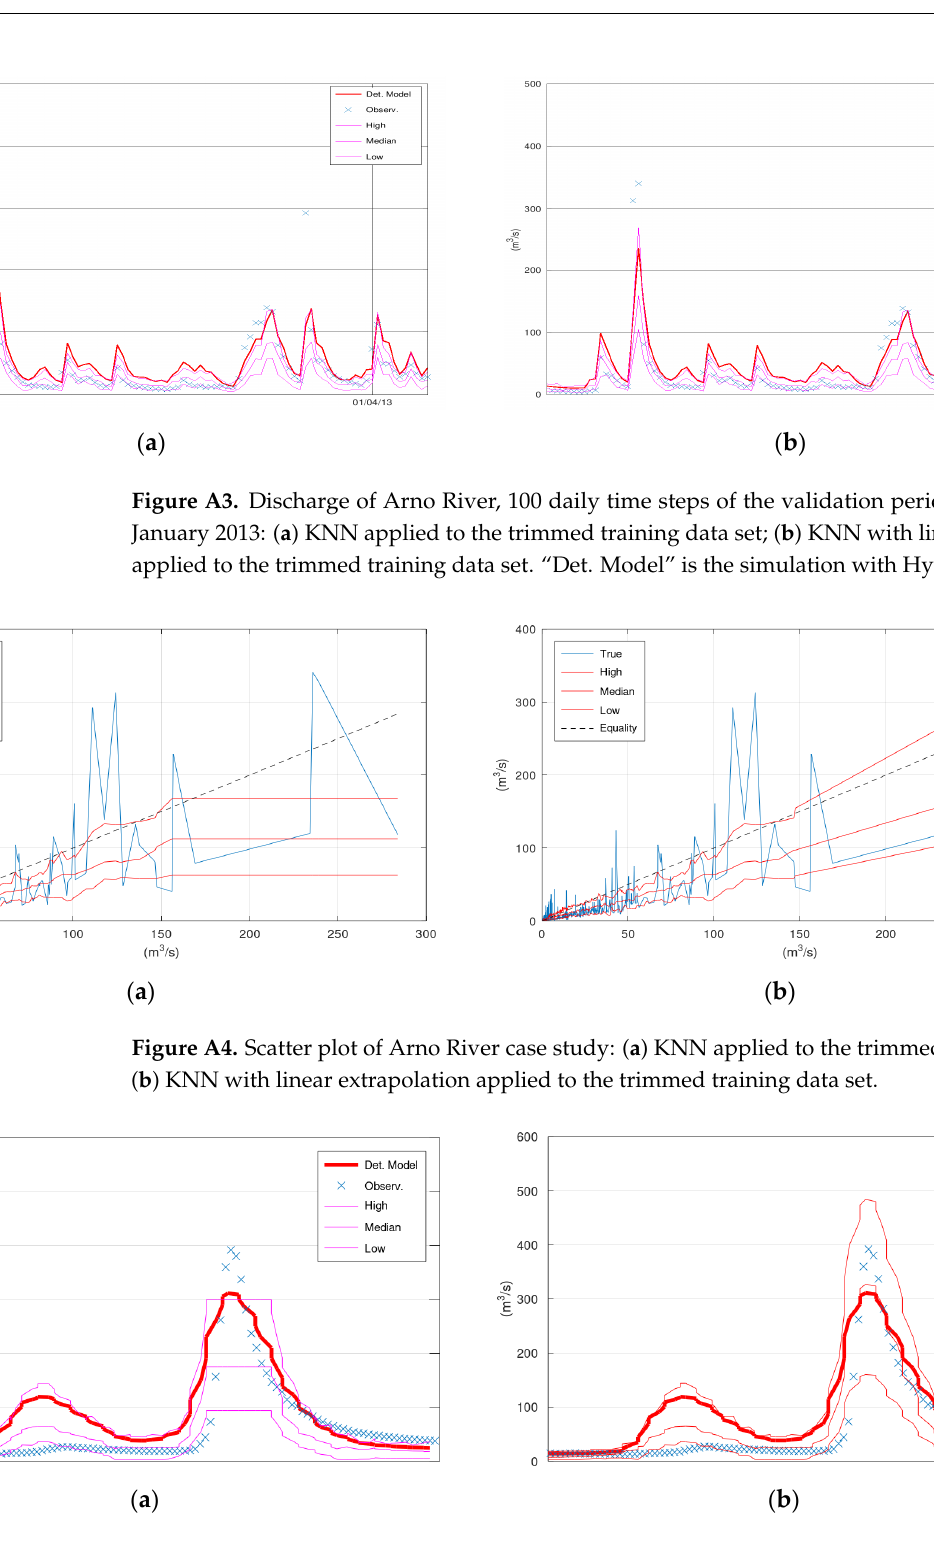
Figure A5. Discharge of Sieve River, 150 hourly time steps of the validation period starting from 5 January 1996: ( a ) KNN applied to the trimmed training data set; ( b ) KNN with linear extrapolation applied to the trimmed training data set. “Det. Model” is the simulation with HyMod.